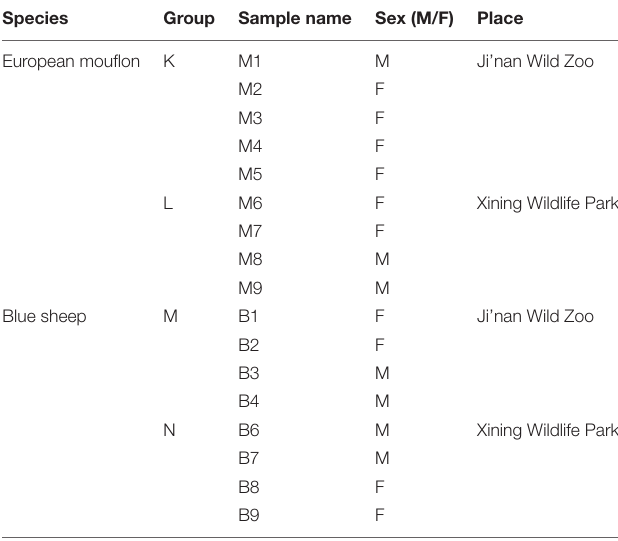
TABLE 1 | Information for fecal samples from European mouflon and blue sheep. Species Group Sample name Sex (M/F) Place European mouflon